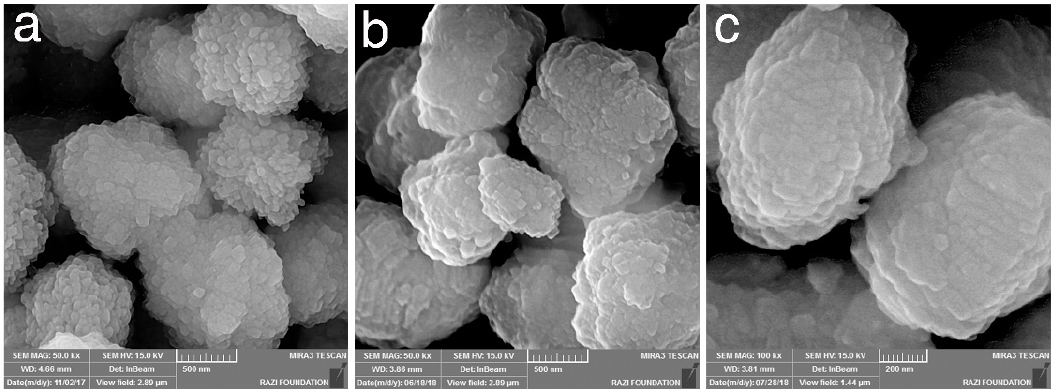
Fig. 1. FE-SEM images of (a) ZSM-5, (b) HPA-ZSM-5, (c) the used HPA-ZSM-5 Figure 1. FE‐SEM images of (a) ZSM‐5, (b) HPA‐ZSM‐5, (c) the used HPA‐ZSM‐5